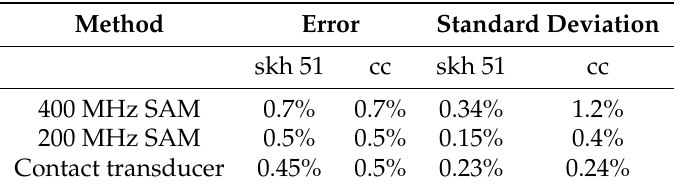
Table 3. Error estimation and standard